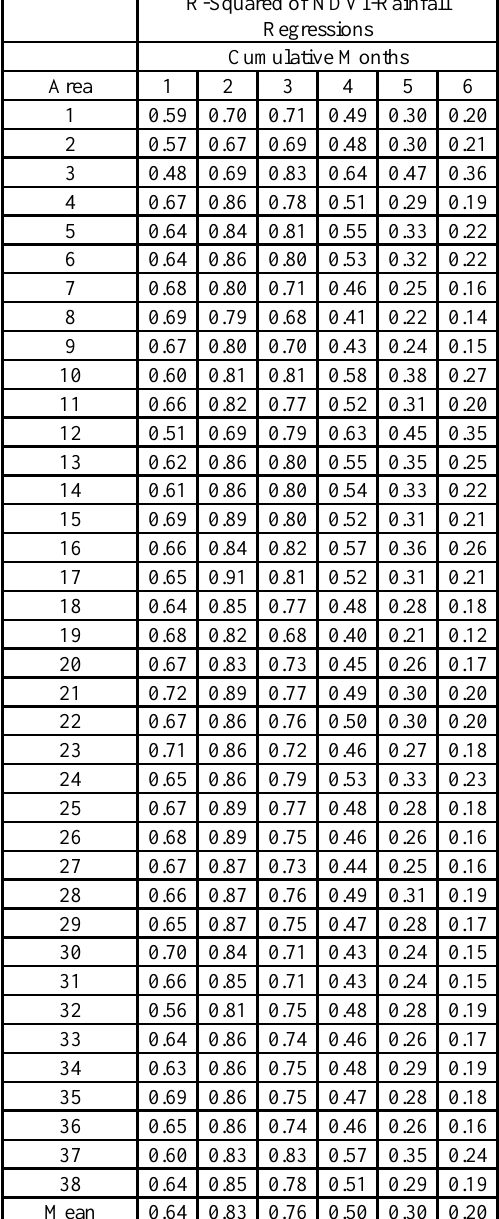
Figure 3: Land-cover classes for SVM classification.